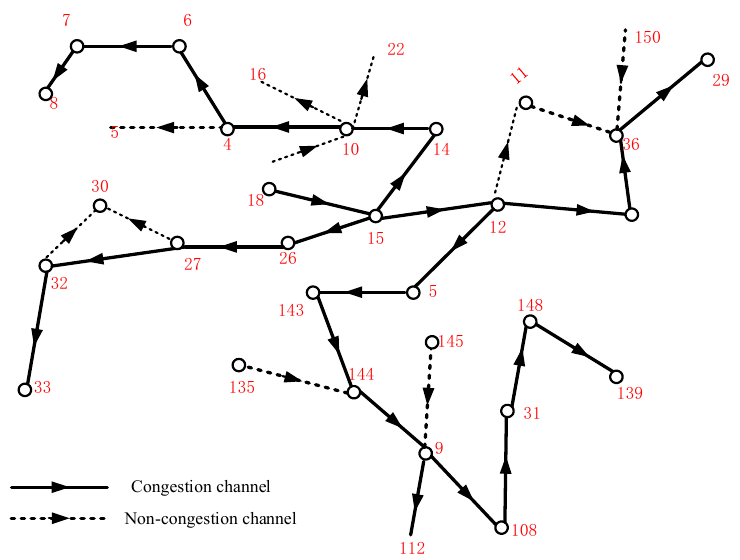
Figure 7. Intermediate power flow congestion channel in Case 1. From the identified congestion channels, the starting line of all the congested channels was line 15–18, indicating that a large amount of active power was transmitted outward through line 15–18. This reflects a severe imbalance of active power in the area, far exceeding the transmission limit of the line. The injection power of Bus 18 was reduced, and the injection power of the receiving bus of the congested channel was increased by equalizing the sending and receiving buses of the generated congestion channel. The adjustment values calculated using Equation (11) are shown in Table 1. Table 1. Active power adjustment results. Channel